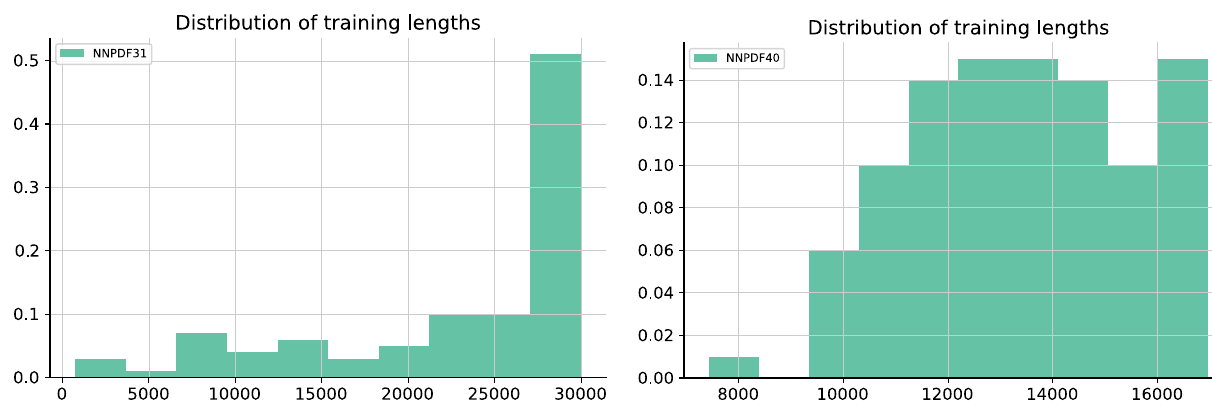
Fig. 12 Distribution of training lengths, defined by the optimal stopping point of each replica, in fits to a common global dataset based on the NNPDF3.1 (left) and NNPDF4.0 (right panel) methodologies